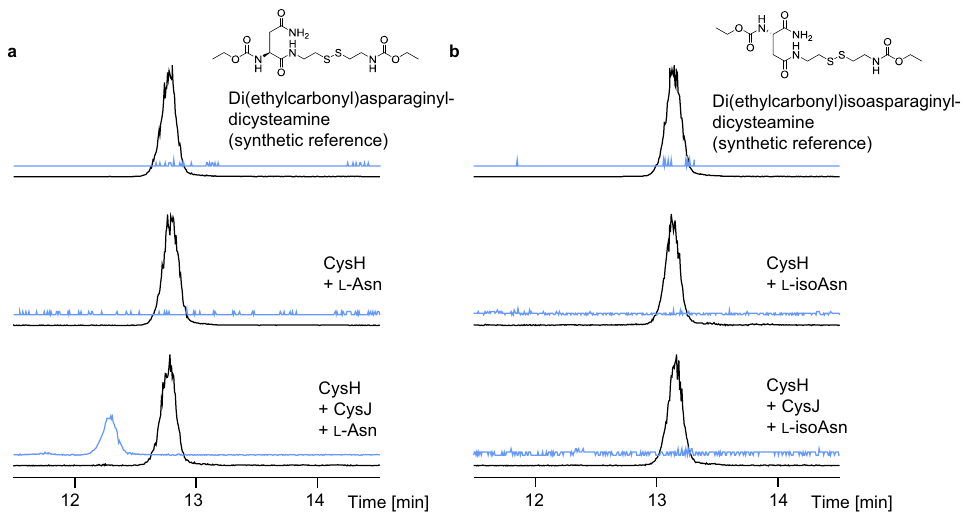
Fig. 4 Hydroxylation of CysH-bound L -asparagine by CysJ. HPLC-MS analysis of cysteamine-unloaded and derivatized substrate from the CysH protein. EICs 411.1 m/z [M + H] + are shown in black and EICs 427.1 m/z [M + H] + (Di(ethylcarbonyl)-hydroxy- L -(iso)asparaginyl-dicysteamine) are shown in blue. a Di(ethylcarbonyl)- L -asparaginyl-dicysteamine synthetic reference. CysH-bound L -asparagine unloaded and derivatized showed the same retention time as the synthetic reference. Incubation of CysH with CysJ and L -asparagine lead to hydroxylation of L -asparagine and different retention times of the unloaded substrate compared to the reference. b Di(ethylcarbonyl)- L -isoasparaginyl-dicysteamine synthetic reference. CysH-bound L -isoasparagine unloaded and derivatized showed the same retention time as the synthetic reference. No hydroxylation occurred upon the addition of